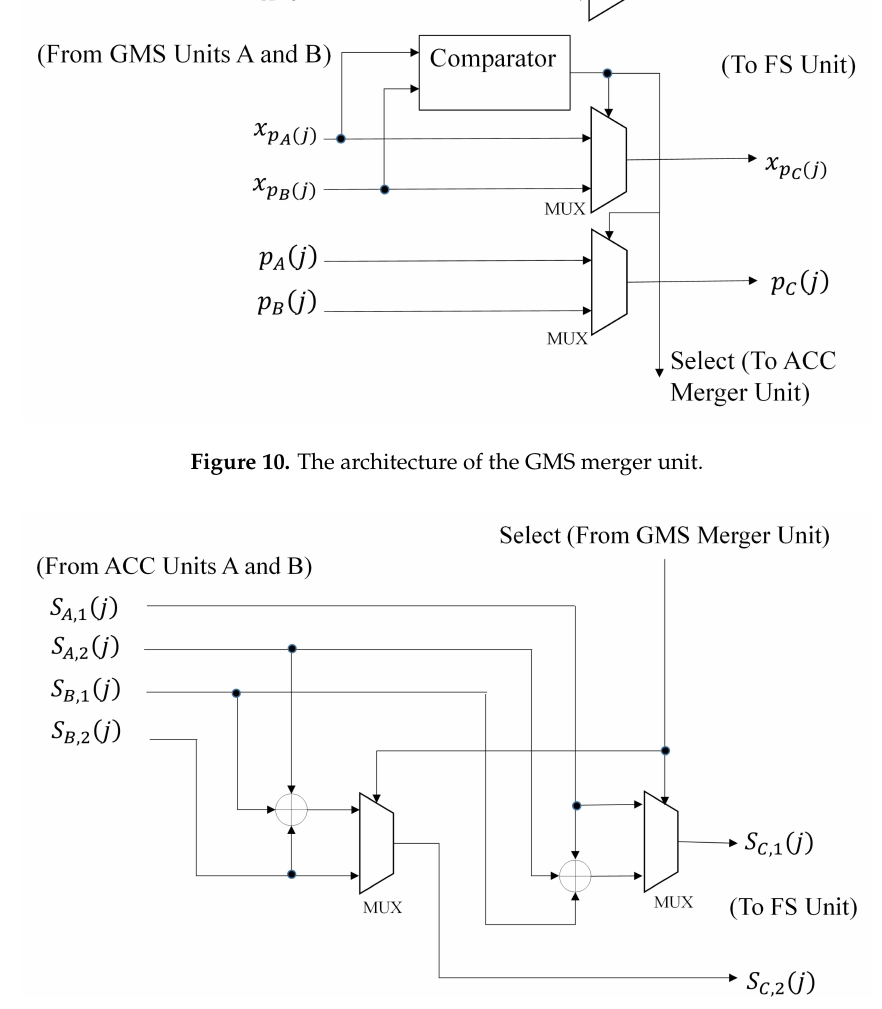
Figure 11. The architecture of the ACC merger